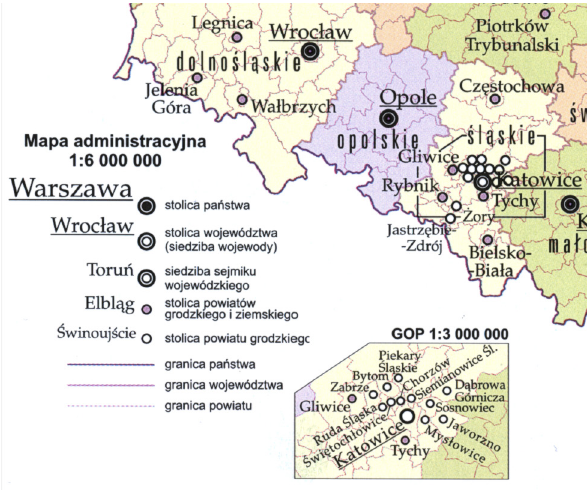
Fig. 4. Symbols of order used to show the administrative functions of